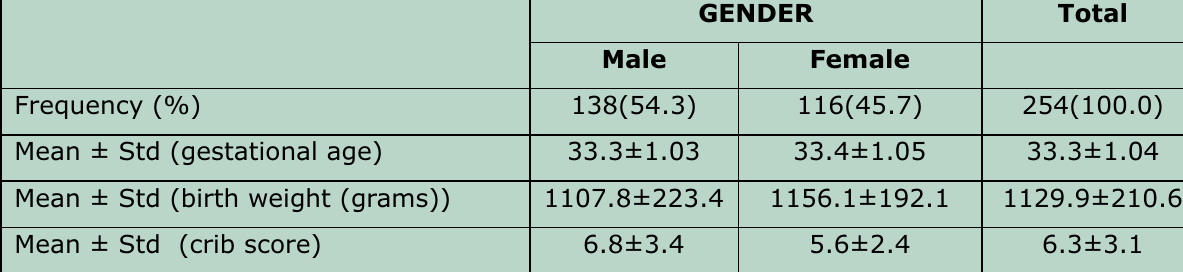
Table-I: D  emographic Characteristics of Study